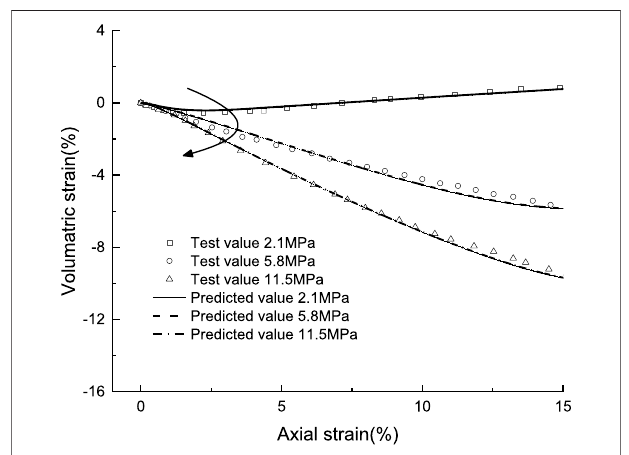
FIGURE 7 | Volume strain variation of undrained shear under different initial con fi ning pressures.